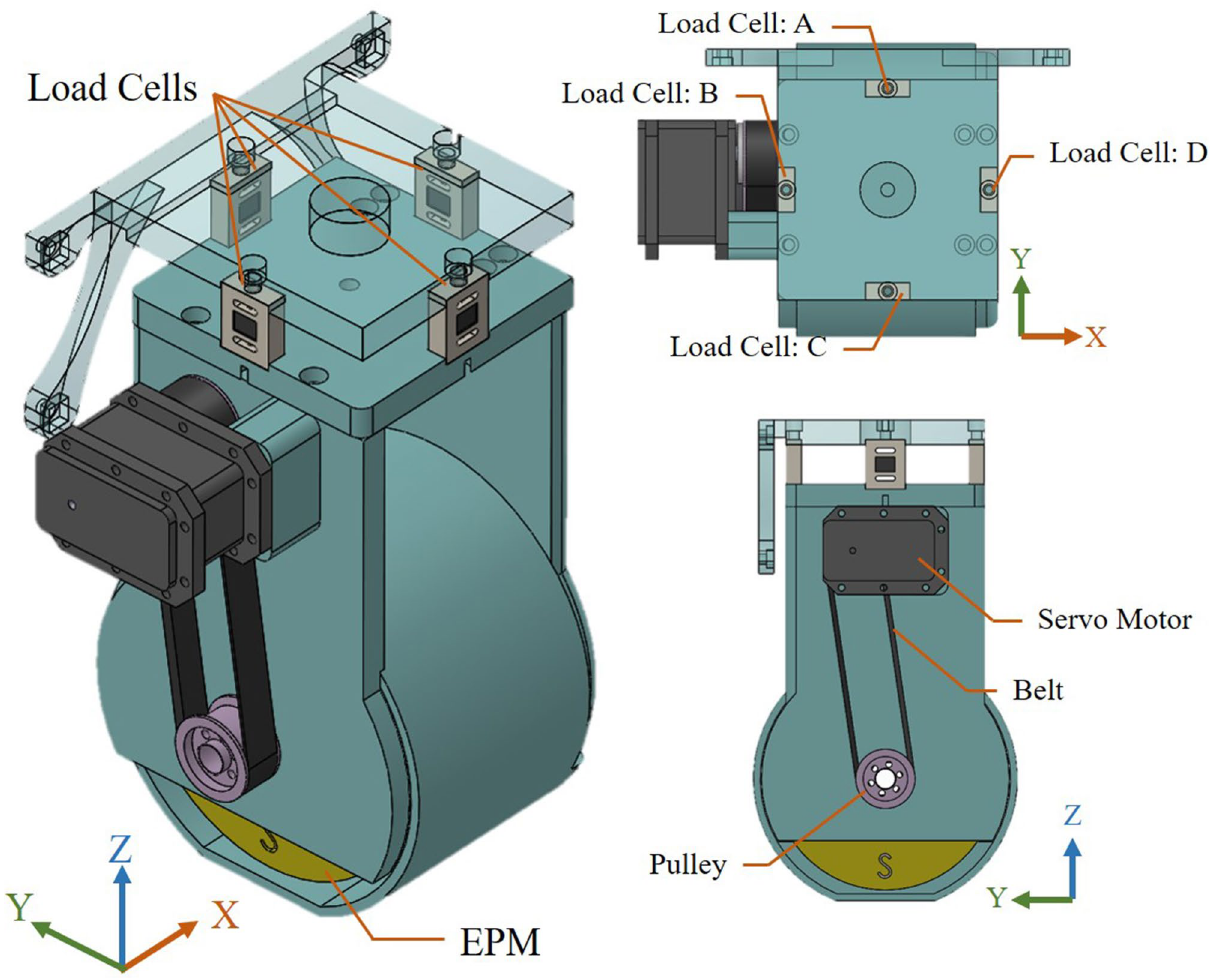
Figure 2. Schematic illustration showing the architecture of proposed force sensing system, featuring load cells installed between the robot arm and the container holding a large permanent magnet. Vertical distance from EPM to MC (cm) Detectable radius (cm) Maximum attraction